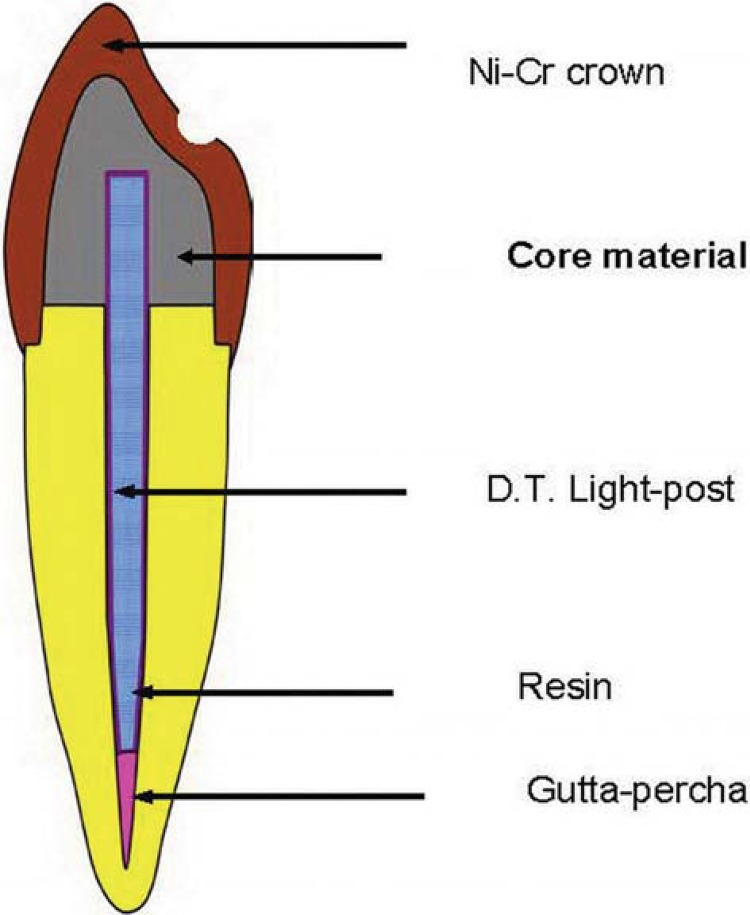
Schematic illustration of tooth specimen with restoration